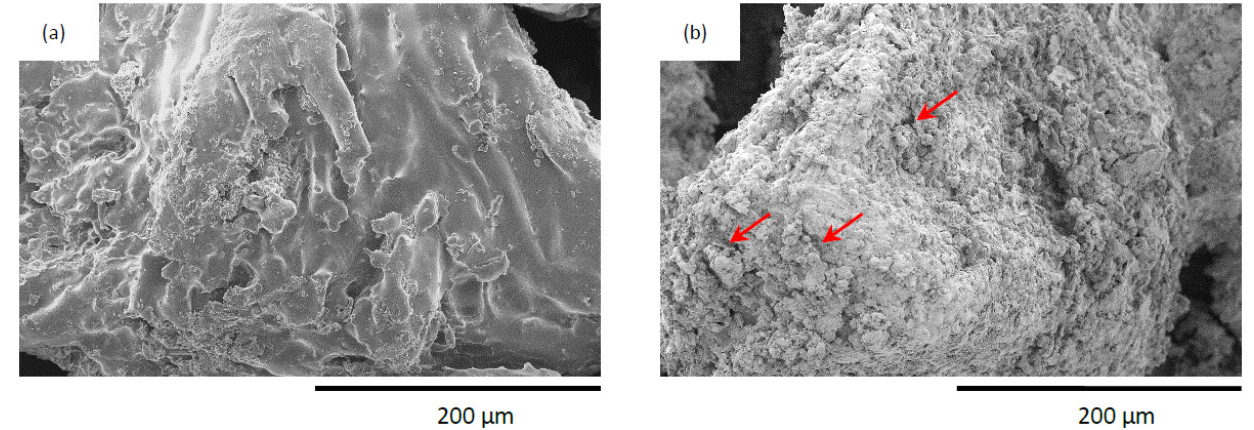
Figure 3. External morphology of ( a ) apricot filler, and ( b ) casein/apricot filler.